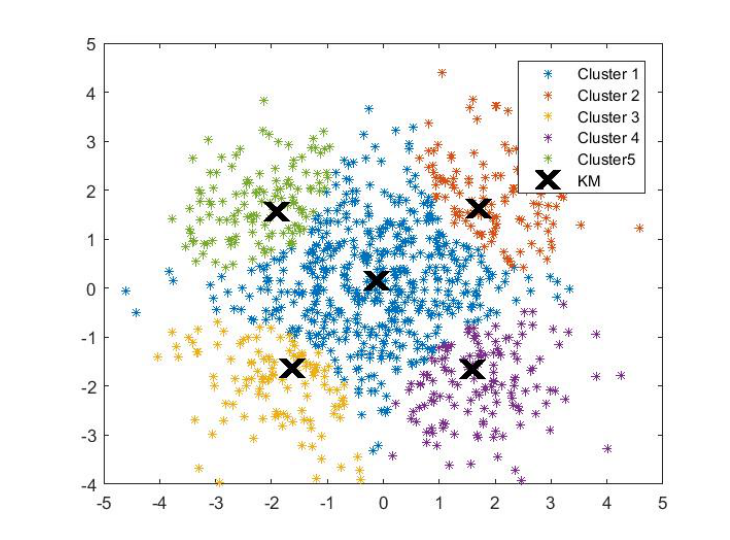
Figure 6. Illustration of order selection under the sparse matrix.